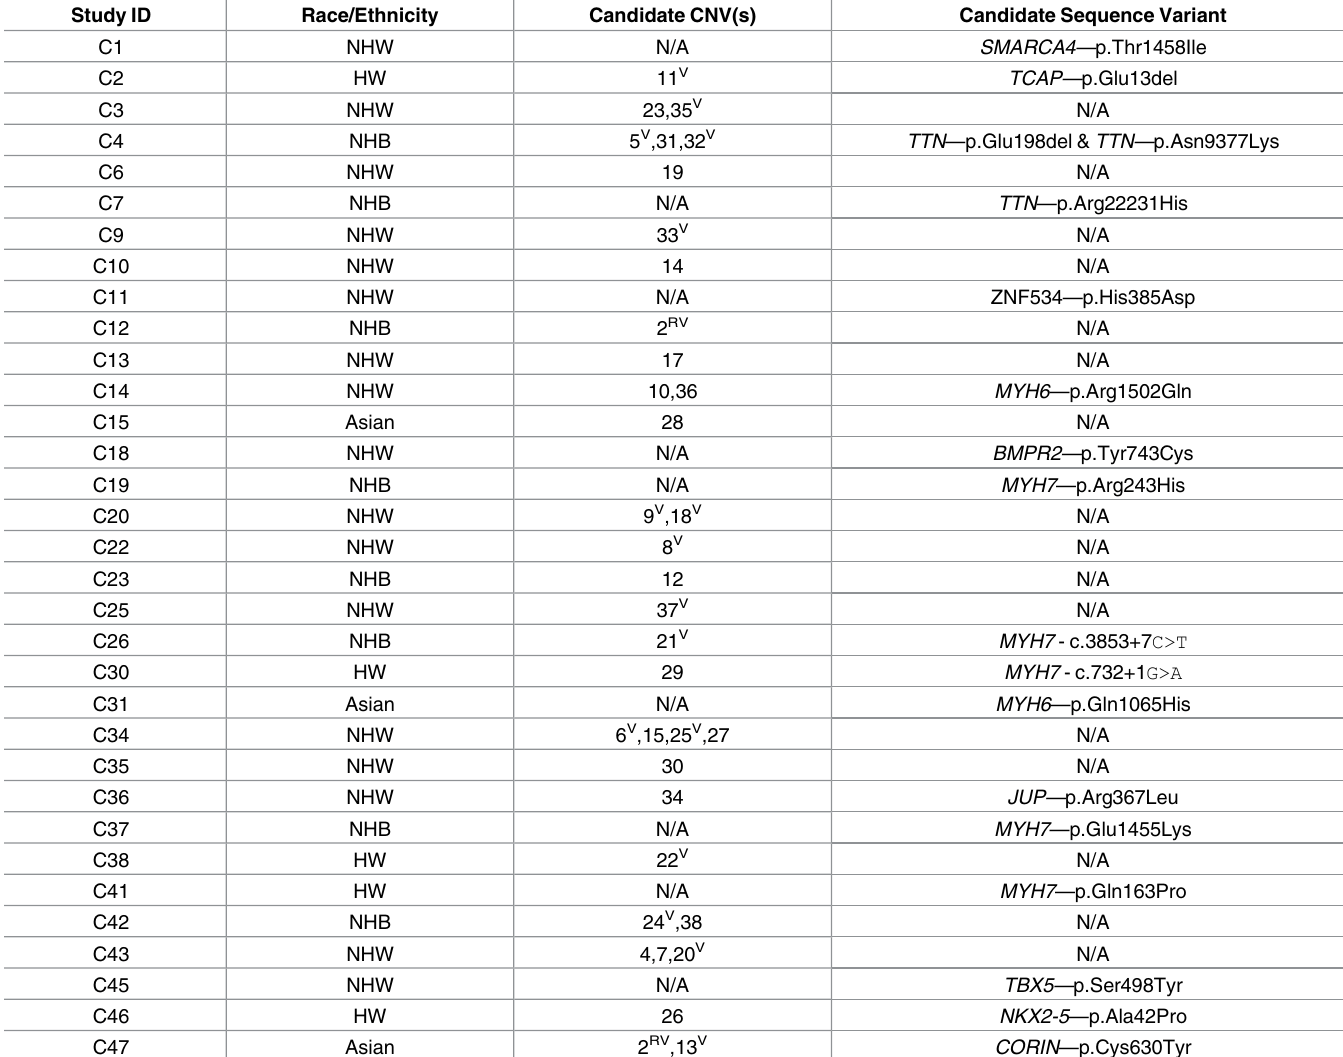
Table 5. Candidate EA-associated genetic variants identified in each EA case.